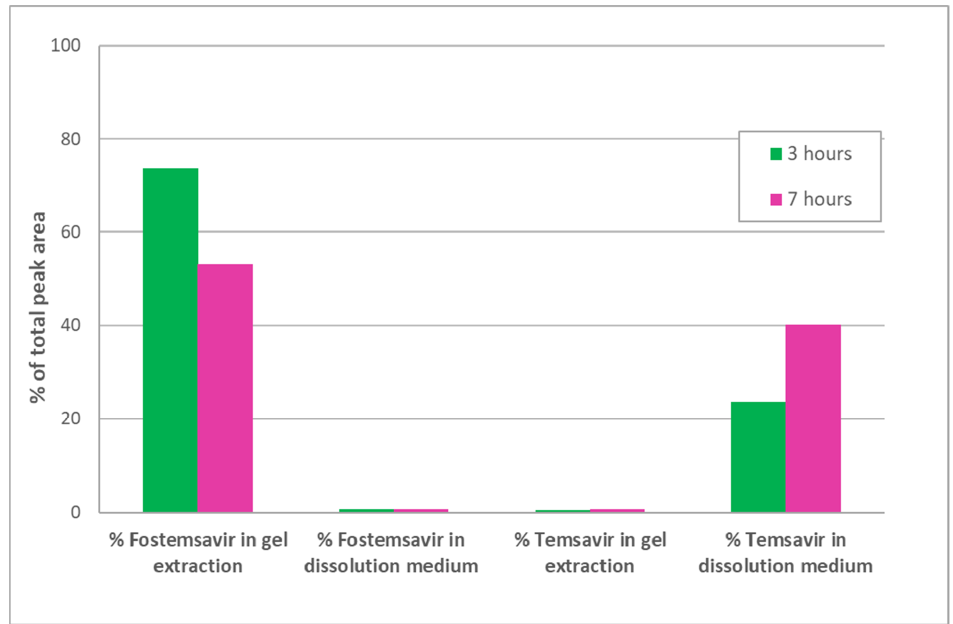
Figure 6. Concentration of prodrug fostemsavir and parent temsavir in fostemsavir + added tromethamine ER tablets, and in dissolution media after 3 h and 7 h hydration.